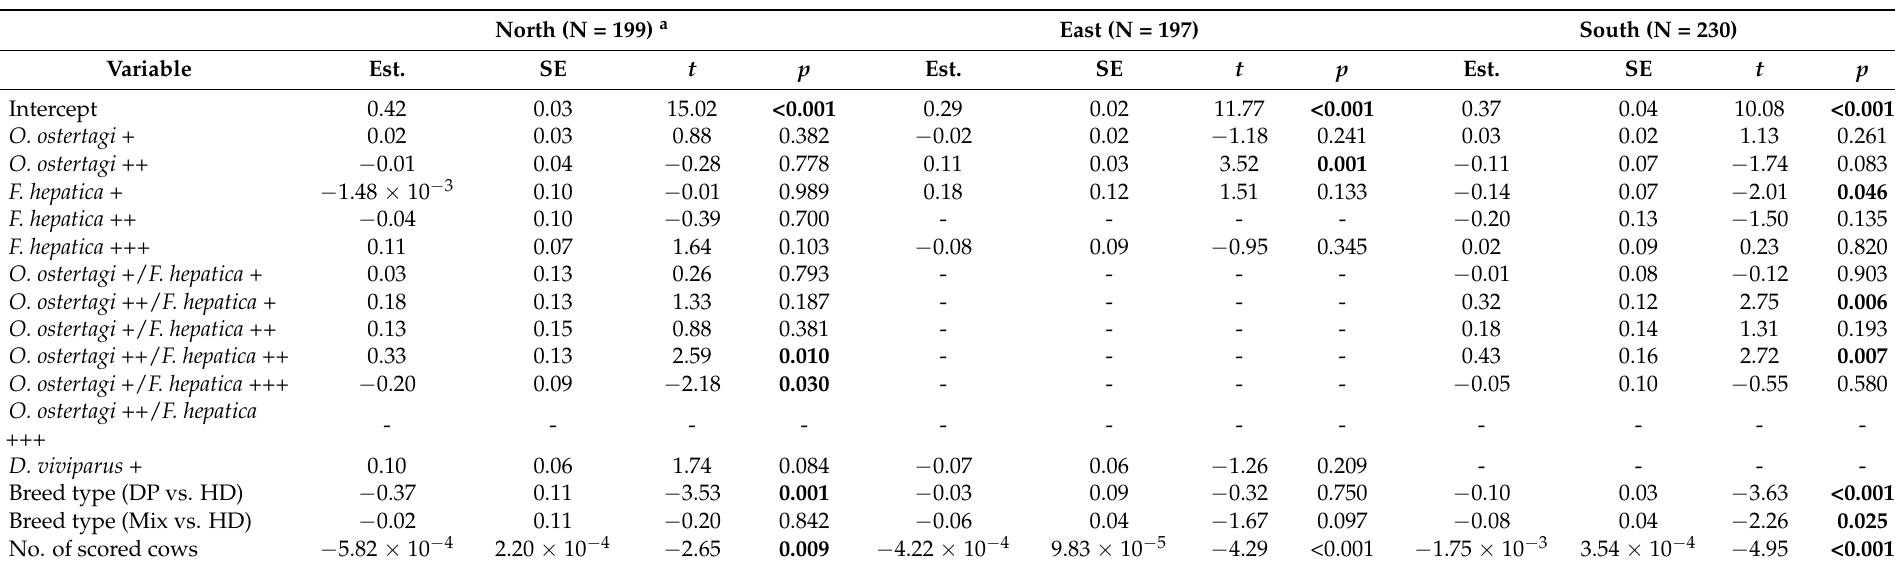
Table 5. Results from linear models investigating the association of O. ostertagi , F. hepatica and D. viviparus BTM ELISA results and the proportion of cows with a suboptimal body condition score. Full models were significantly different from null models containing only an intercept term (North: Df = 14, F = 4.1, p < 0.001; East: Df = 8, F = 7.1, p < 0.001; South: Df = 13, F = 4.2, p < 0.001). Significant p -values are printed in bold. Seropositivity categories are defined as follows: O. ostertagi : +: ODR ≥ 0.5, ++: ODR ≥ 0.8; F. hepatica : +: 30% < S/P ≤ 80%, ++: 80% <